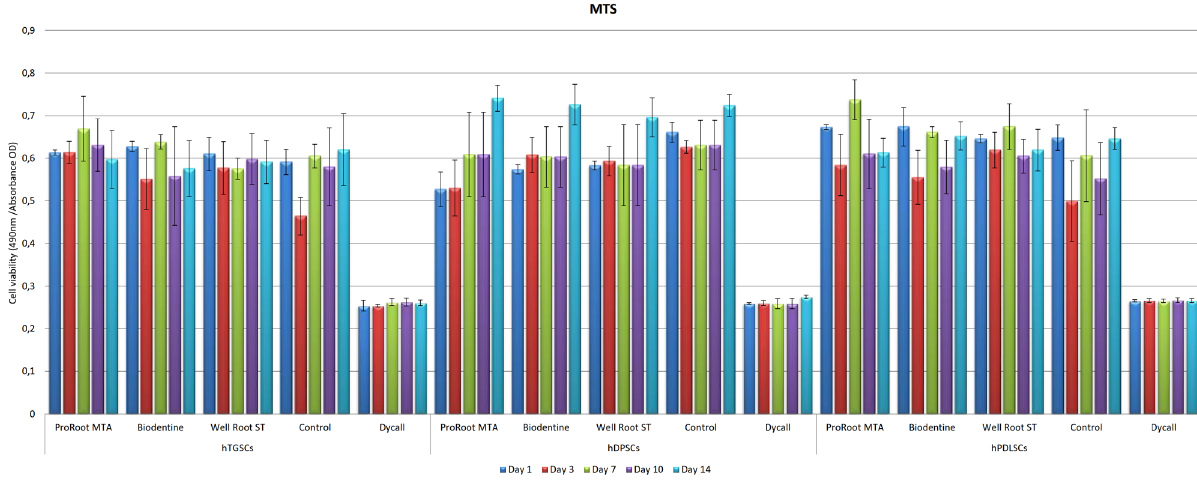
Figure 2- Tested materials effects on MTS results. Cell viability was evaluated by MTS assay at the 1 st , 3 rd , 7 th , 10 th and 14 th days. hDPSCs: human dental pulp stem cells; hPLSCs: human periodontal ligament stem cells; hTGSCs: human tooth germ stem cells (Significant: *p<0.05)